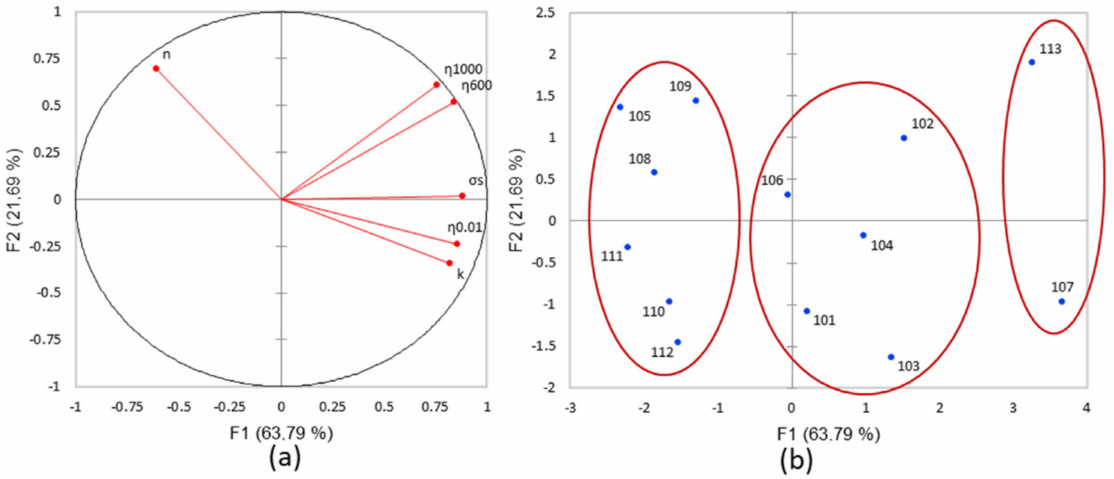
Figure 3. ( a ) PCA loading plot of the rheological parameters (variables) and ( b ) scatter plot of the products (individuals) for the flow tests (PC1 63.79%, PC2